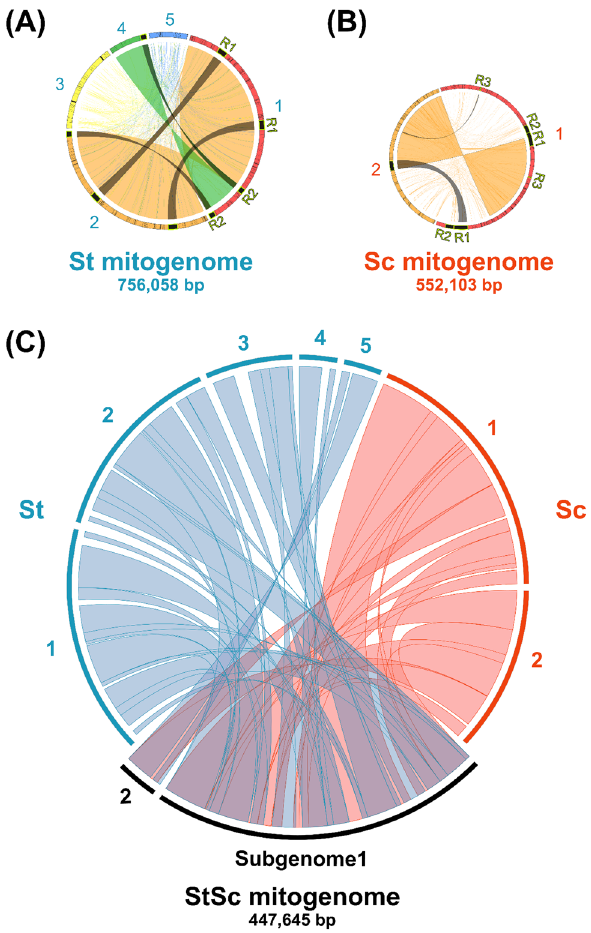
Figure 1. Chord diagram of three Solanum mitogenomes. ( A – C ) represent the homologous regions of the subgenomes. R1 to R3 represent the large repeats that might cause homologous recombination among the corresponding subgenomes. St : S. tuberosum accession no. PT56, Sc: S. commersonii accession no. Lz3.2, StSc: somatic hybrid accession no. HA06-9.